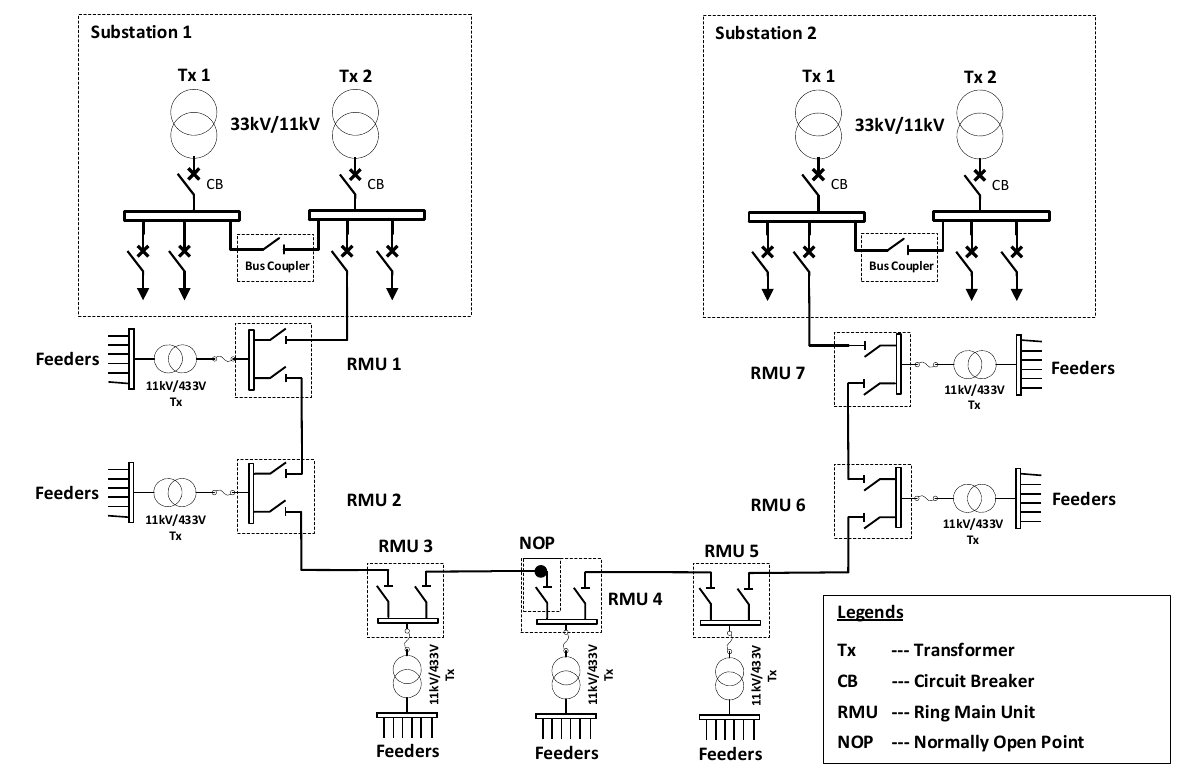
Figure 3. The 11kV distribution feeder system. Figure 3. The 11 kV distribution feeder system.